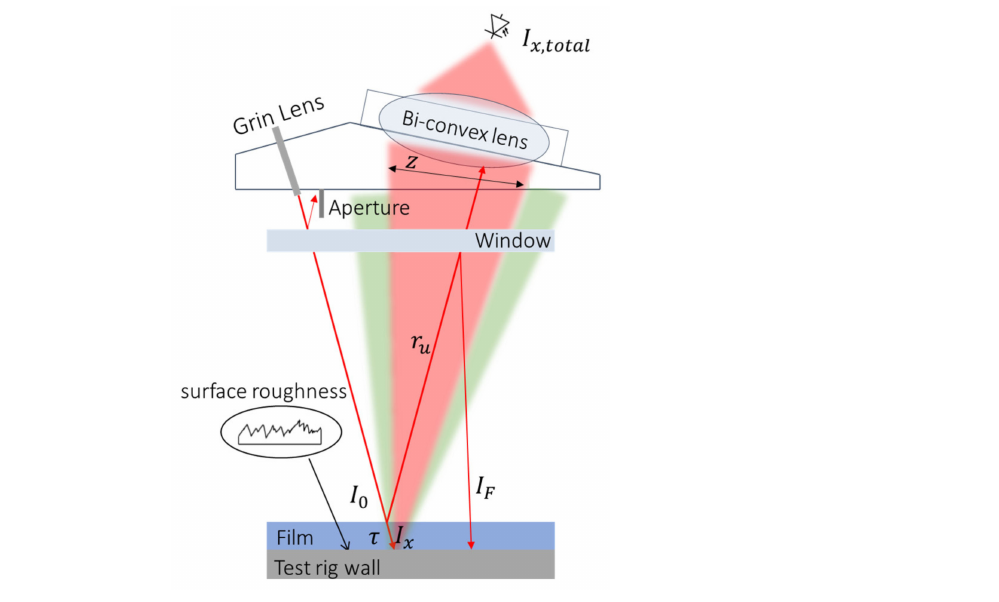
Figure 4. Different reflections from the laser beam when entering the channel and the diffuse reflection from the channel wall. I x,total : intensity of the laser beam focused on the detector, I x : intensity transmitted through the film, I r : intensity reflected from the film surface, I 0 : intensity before transmitting through the film, I w : intensity reflected from the window surface, τ : part of the transmitted and not absorbed light, z: portion of the diffuse radiation that is focused onto the